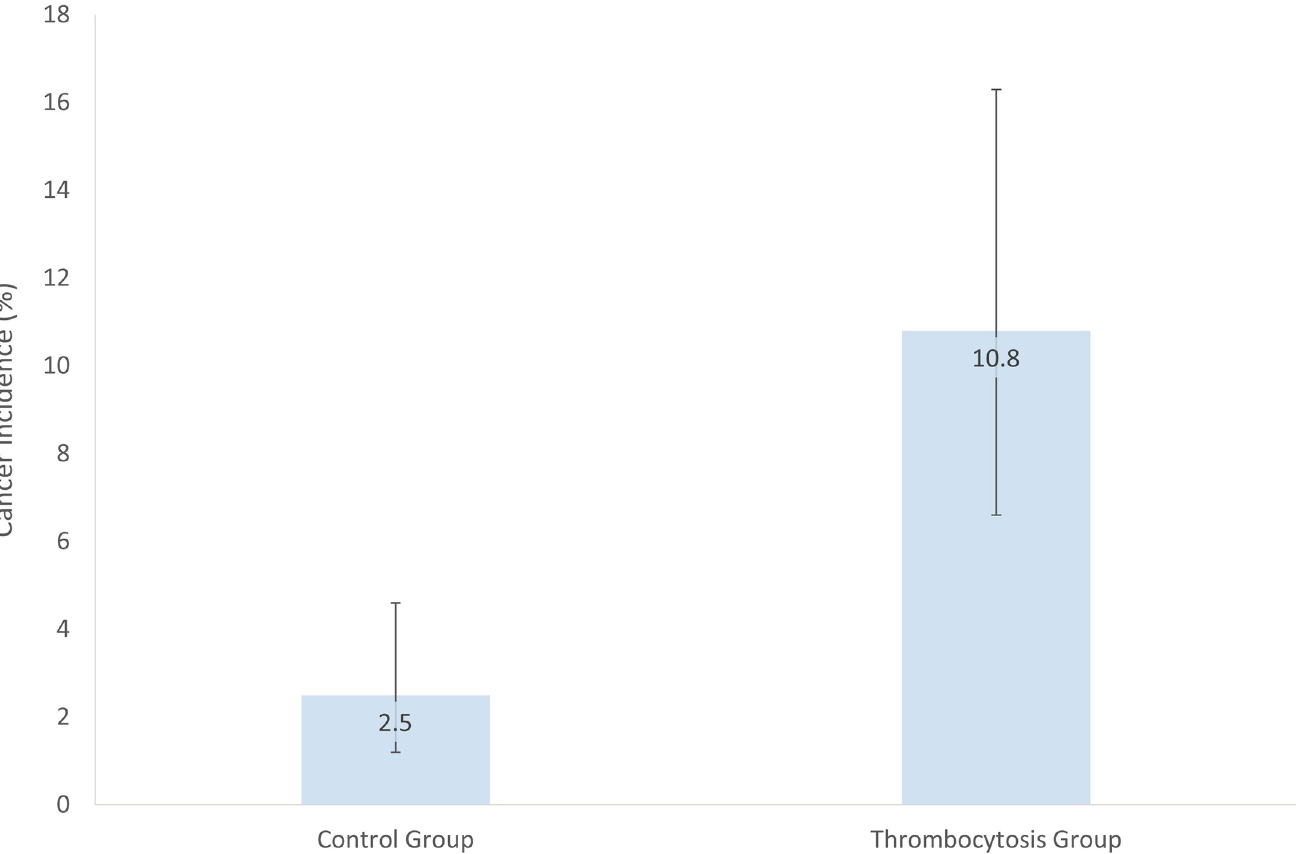
Fig 2. Chart demonstrating cancer incidence in control group and thrombocytosis group with 95% confidence intervals shown.